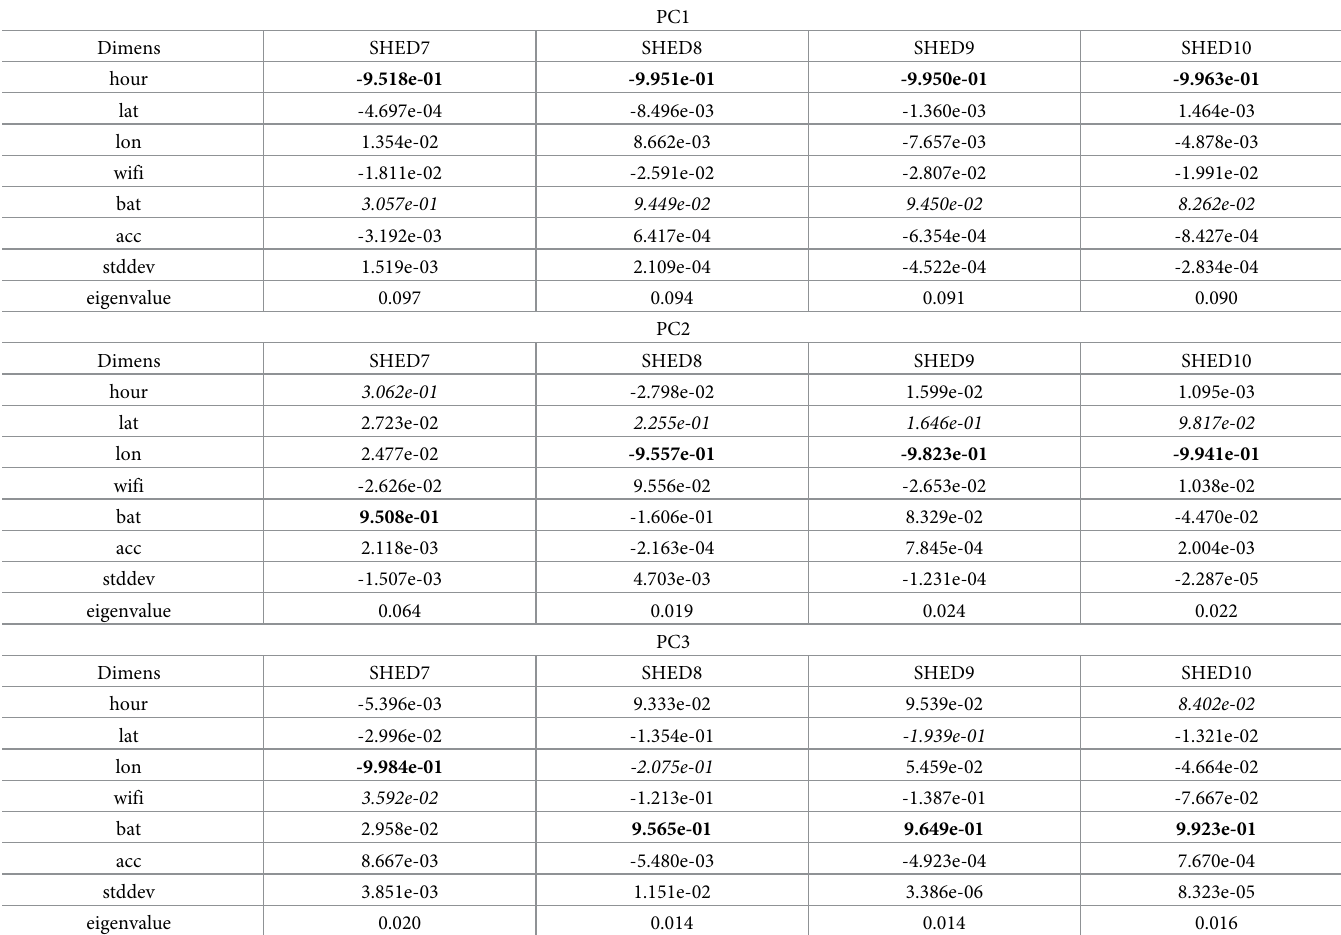
Table 5. Eigenvectors and eigenvalues for the first three principal components for each